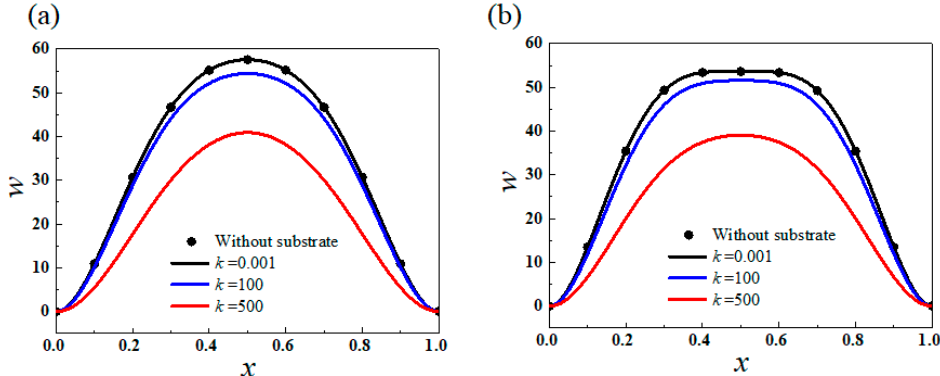
Figure 4. ( a ) The first order and ( b ) the second order vibration modes of the first-order buckling with different substrate stiffness or without substrate when P = 10 × π 2 .